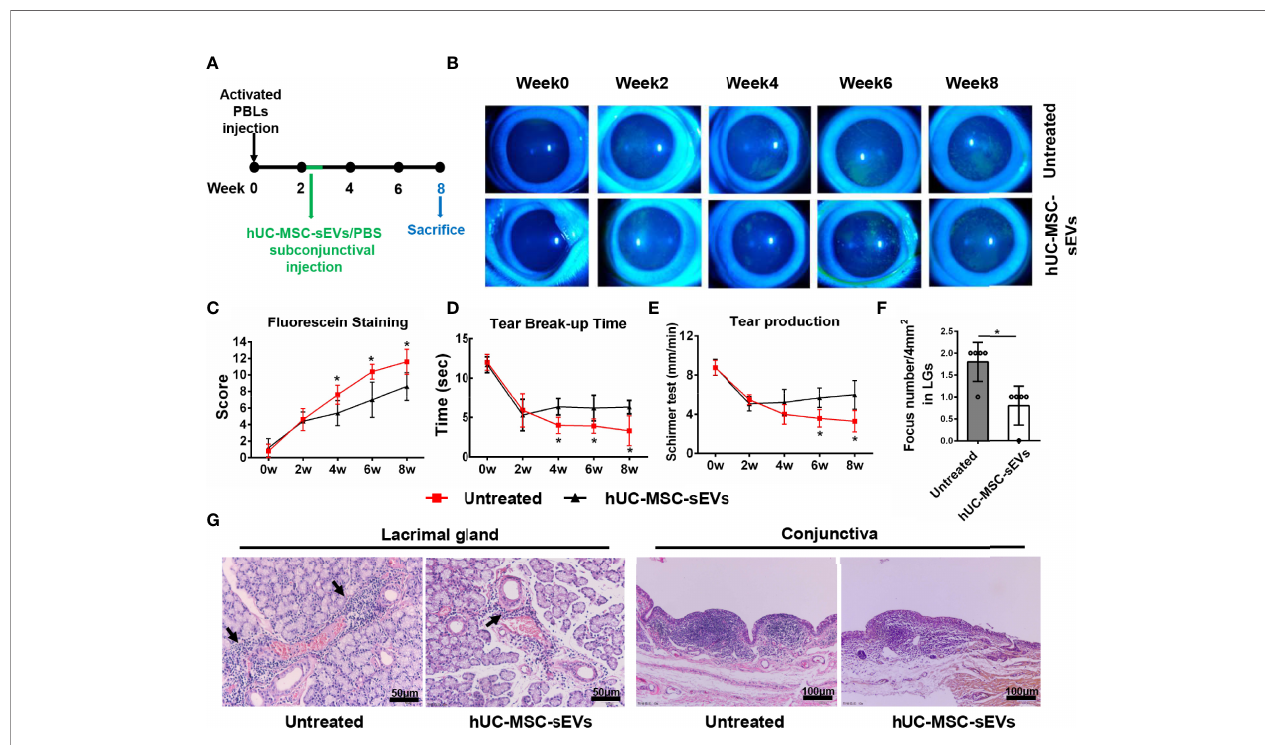
FIGURE 4 | The therapeutic effects of hUC-MSC-sEVs on rabbit autoimmune dacryoadenitis. (A) Schematic representation of hUC-MSC-sEVs administered at the developed stage of rabbit autoimmune dacryoadenitis. (B, C) Corneal fl uorescein staining images and grading scores. (D) Tear break-up time. (E) Tear production. (F) Numbers of lymphocytic foci per 4 mm 2 in LGs. (G) Representative specimens of H&E staining in LGs and conjunctivas. Arrows indicate in fi ltrating lymphocytes. n = 5 rabbits per group (C – F) . Data were shown as mean± SD. *P <